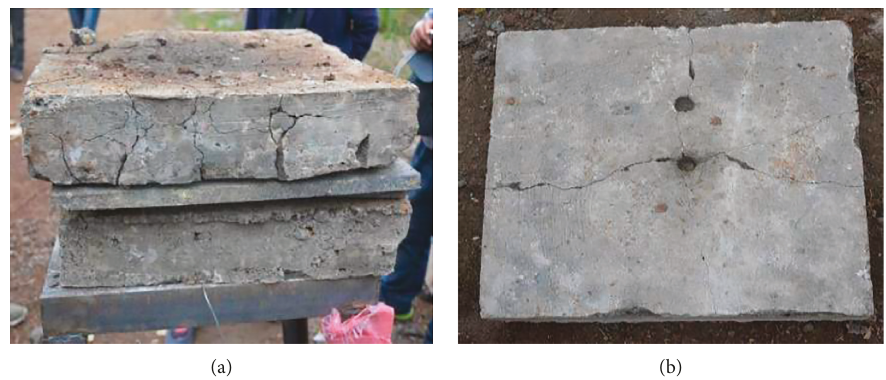
Figure 17: Complete setup for Test 4 (a) and the damage to the base (b).